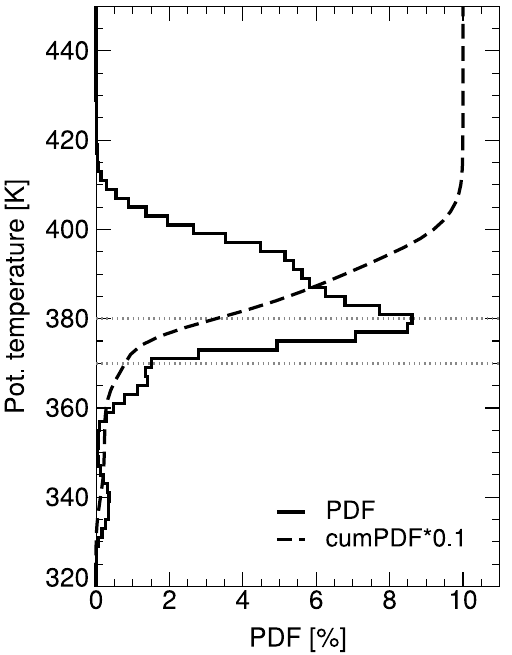
Figure 7. Tropopause potential temperature frequency of occur- rence inside the monsoon anticyclone, calculated as frequency dis- tribution of (WMO) tropopause potential temperature at grid points inside the anticyclone (identified from PV based boundary defini- tion; see Appendix) from all days during July–August 2010–2013. The black dashed line shows the cumulative PDF (scaled by 0.1), the integrated fraction of tropopause occurrence below a certain level. Grey dashed lines highlight the 370–380K layer where the anticyclone tracer was